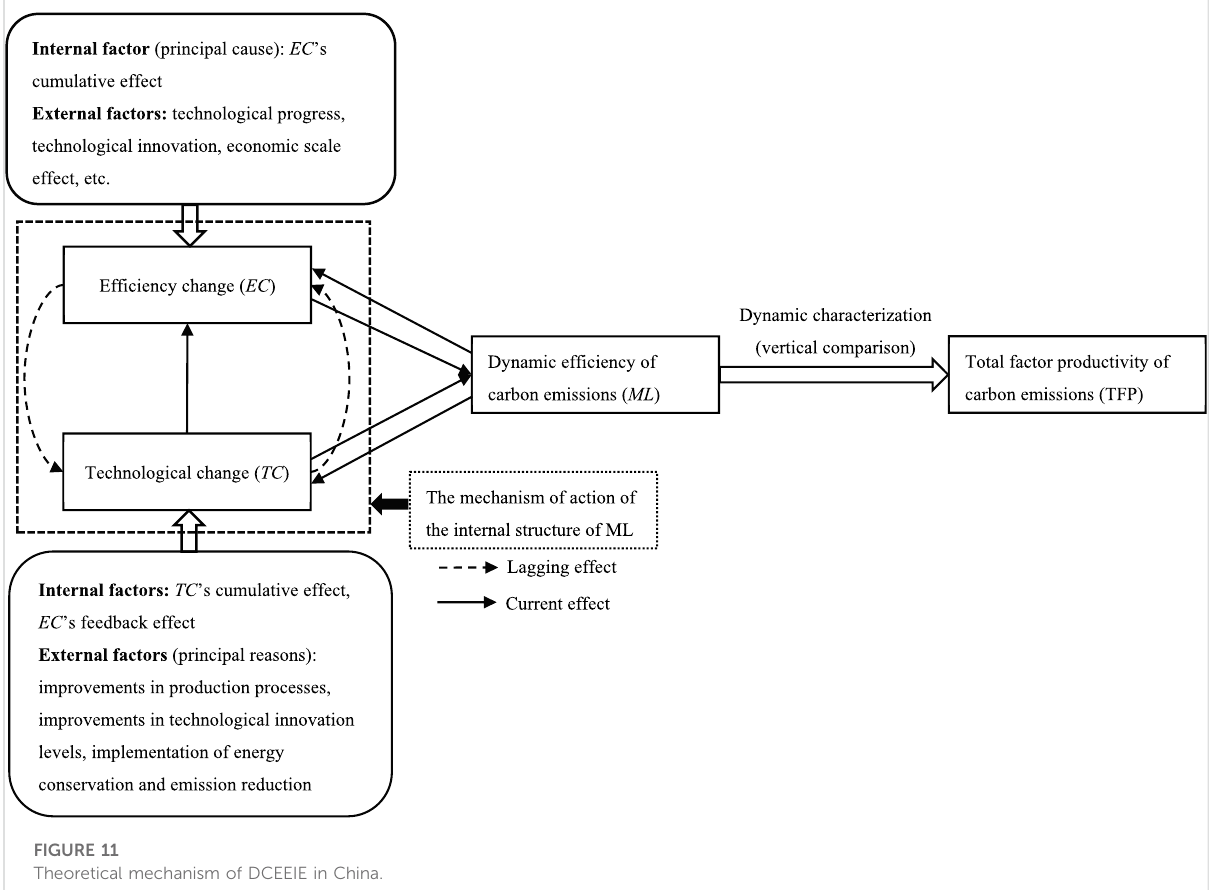
FIGURE 11 Theoretical mechanism of DCEEIE in